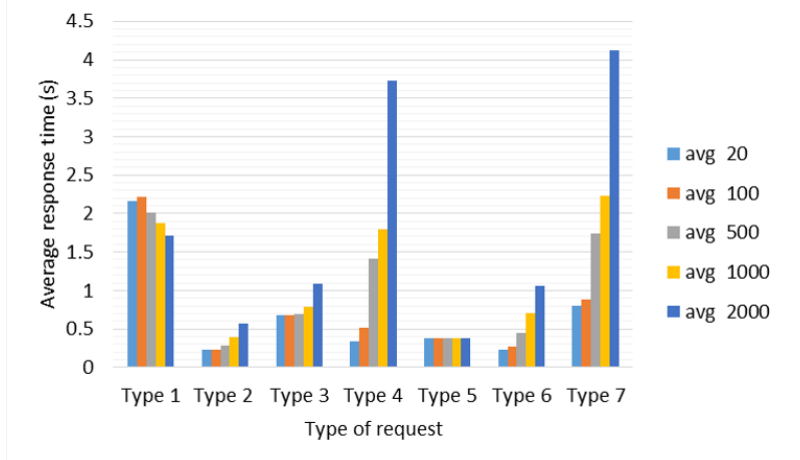
Figure 5. Average response times with respect to the type of request from 20 until 2000 requests.